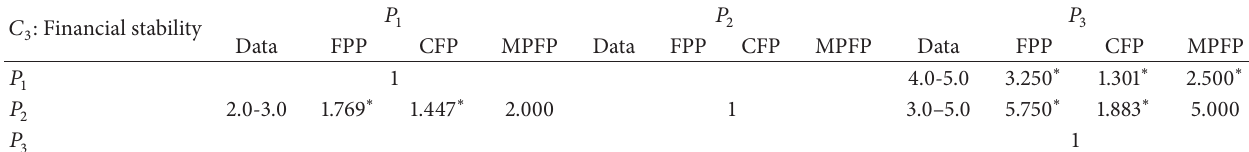
Table 7: Solution matrix of alternatives for 𝐶 3 (Example 1).